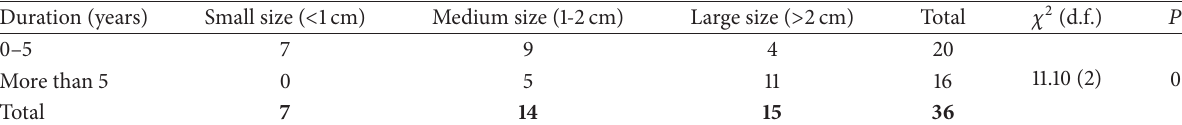
Table 4: Association between duration of disease and size of lesion.